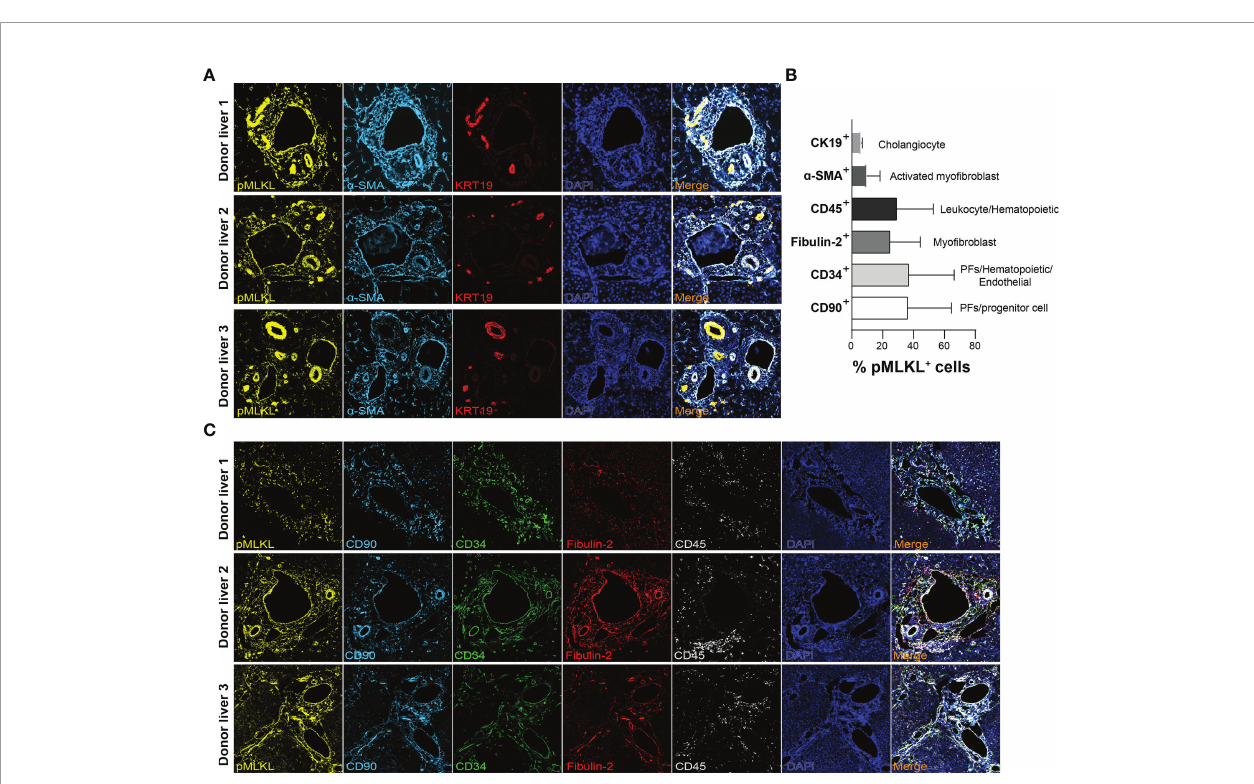
FIGURE 5 | Characterization of periportal cells expressed pMLKL. (A, B) Multiplex immuno fl uorescent staining was performed on T1 graft livers (n=3) for pMLKL, a -SMA, KRT19, CD90, CD34, Fibulin-2, and CD45 (magni fi cation, 400X). (C) The composition of pMLKL+ cells (100%) was calculated as the percentage of cells co-expressed with multiple markers (mean ± SD). The periportal non-parenchymal cells and cholangiocytes predominantly constitute the population co-expressing